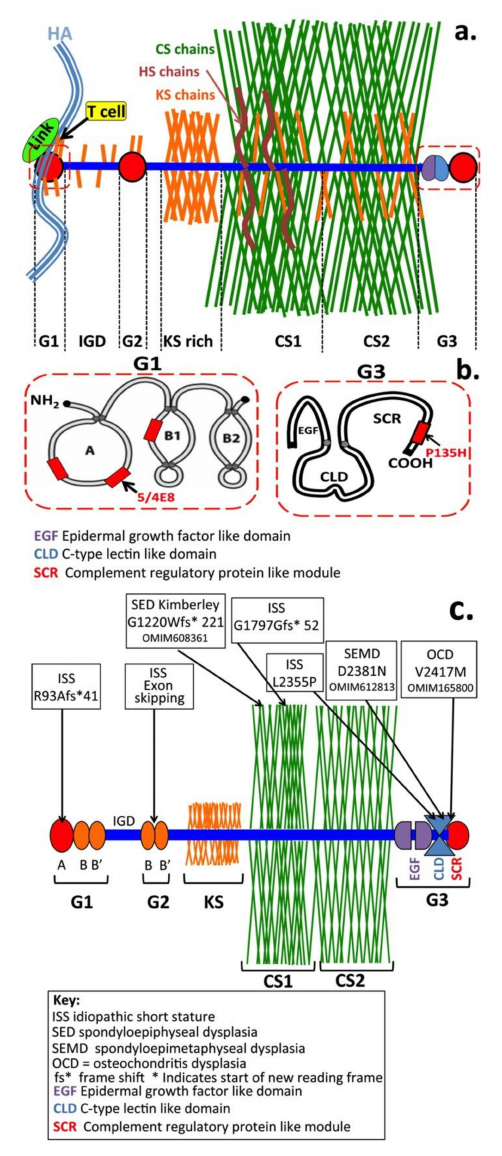
Figure 5. Structural organisation of aggrecan depicting the CS, KS and HS GAG chain distributions ( a ) and T cell receptor epitopes on the G1 and G3 globular domains ( b ). The aggrecanopathies showing regions of aggrecan a ff ected by these mutations and the diseases that result ( c